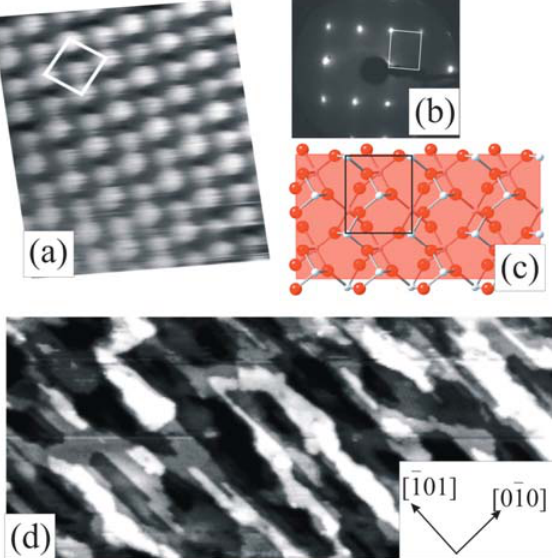
Figure 7 . Surface structure of the SnO (101) surface. (a) Atomically resolved STM image with the 2 (101). Note the missing spots indicating the glide- unit cell indicated. (b) 1x1 LEED-pattern of SnO 2 plane symmetry of the unit cell. (c) Ball-and-stick model of the surface with the unit cell indicated. (d) Large scale STM image of the surface showing the high density of step edges with preferential step edge orientation along the [-101] direction. (reproduced with permission from